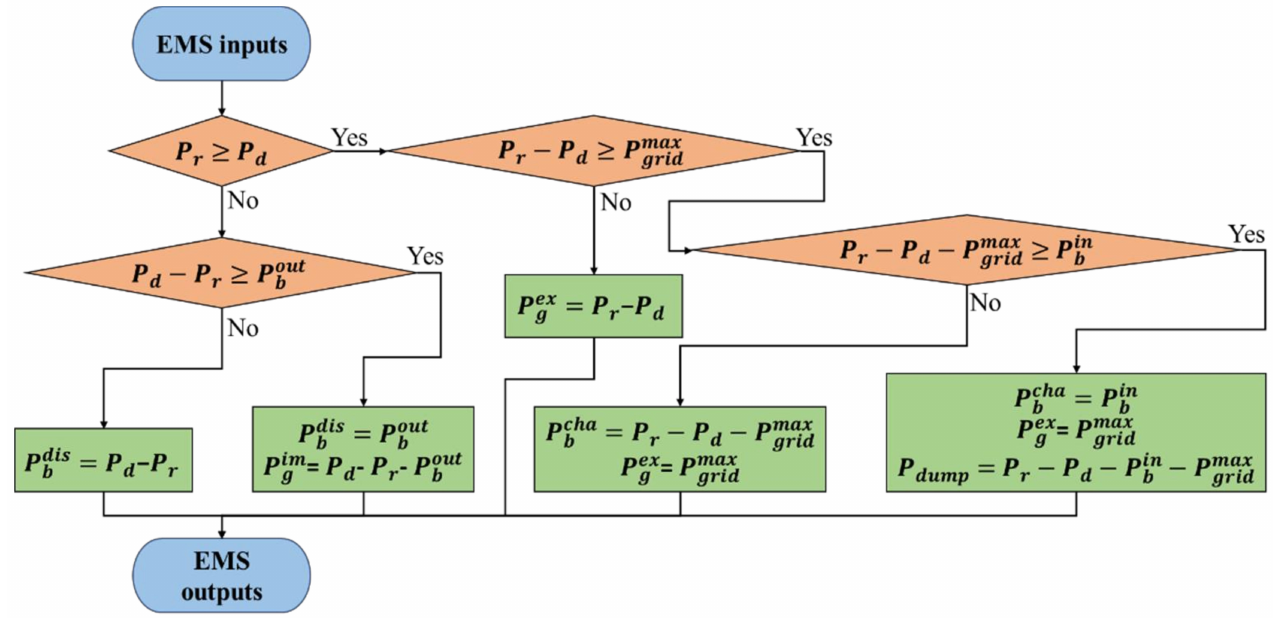
Figure 4. Rule-based flow chart of EMS under Flat-ToU rates during the peak